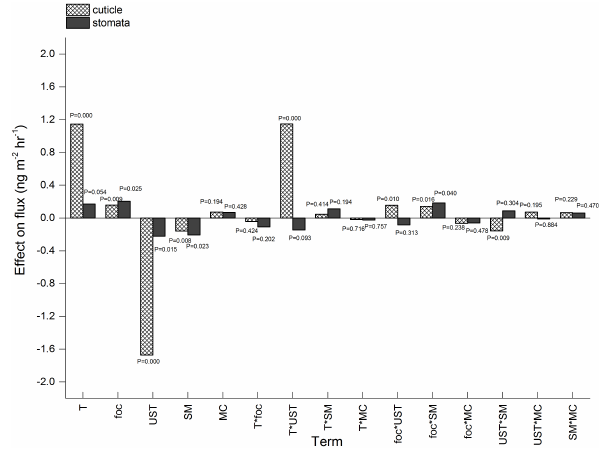
Figure 8. Sensitivity analysis based on the 2 5 factorial design for foliar exchange after pre-screening model variables shown in Table 4 to isolate the significant factors. T denotes surface air temperature; foc denotes fraction of organic carbon in soil; UST denotes friction velocity; SM denotes soil Hg content; MC denotes soil moisture. "*" denotes interaction effects.